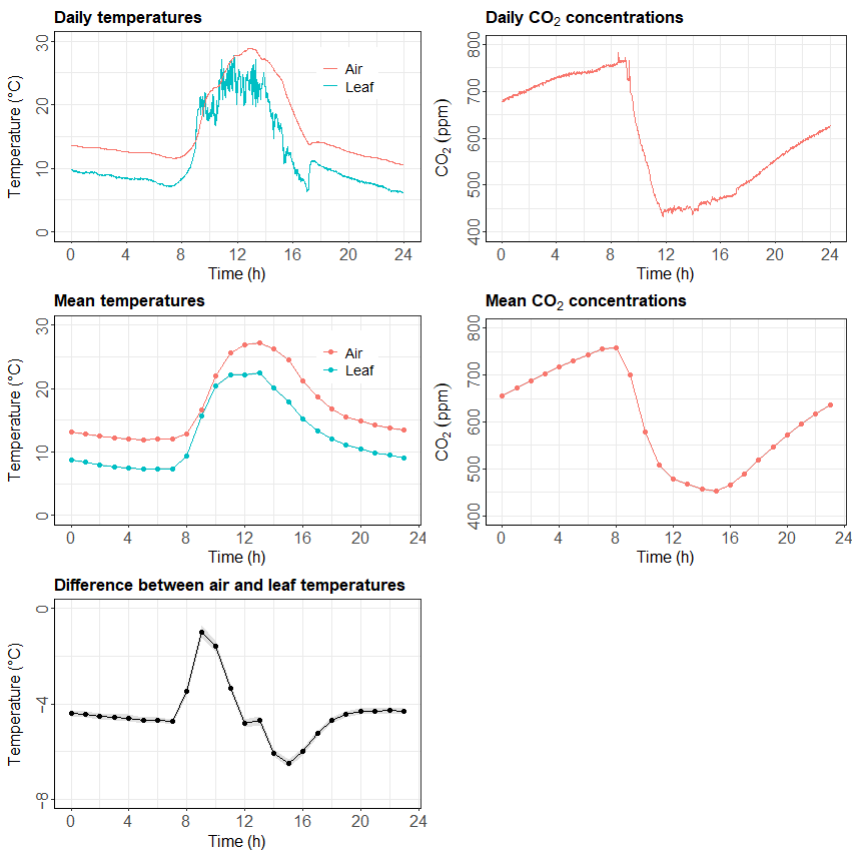
Figure 5. Daily and mean temperatures and CO 2 concentrations for strawberries. Daily values were collected on 1 December 2021. Mean hourly values were calculated from 1 November 2021 to 26 December 2021. The shade indicates a 95% confidence interval for a difference in means. Table 4. Correlations of leaf temperature with other environmental variables under